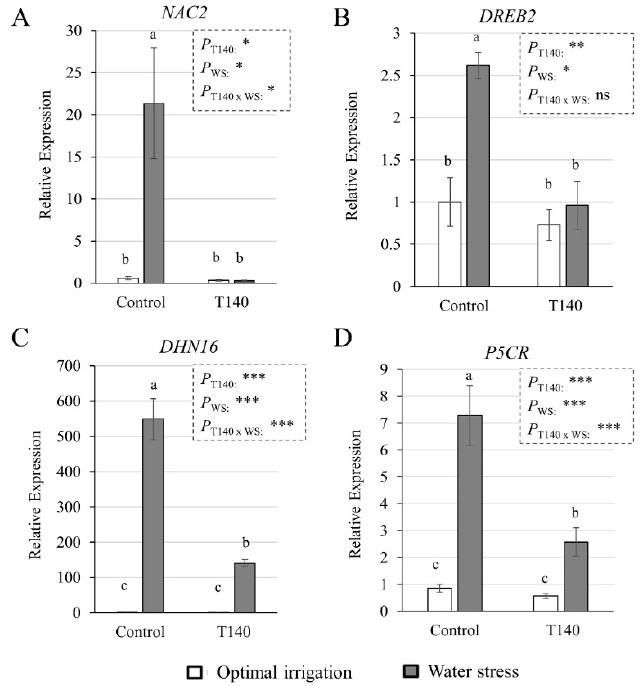
Figure 4. Effect of strain T140 on the expression levels of four water stress (WS) marker genes: ( A ) NAC2 , ( B ) DREB2 , ( C ) DNH16 , and ( D ) P5CR, in 4-week-old wheat seedlings under optimal irrigation and WS (irrigation withdrawn during the third and fourth weeks) conditions. Data are the means of three technical replicates from three biological replicates for each treatment and irrigation condition ( n = 3). Data are displayed as the relative quantity (RQ, 2 − ∆∆ Ct ) of target genes compared to the quantity of the ubiquitin gene used as a reference. Different letters above the bars